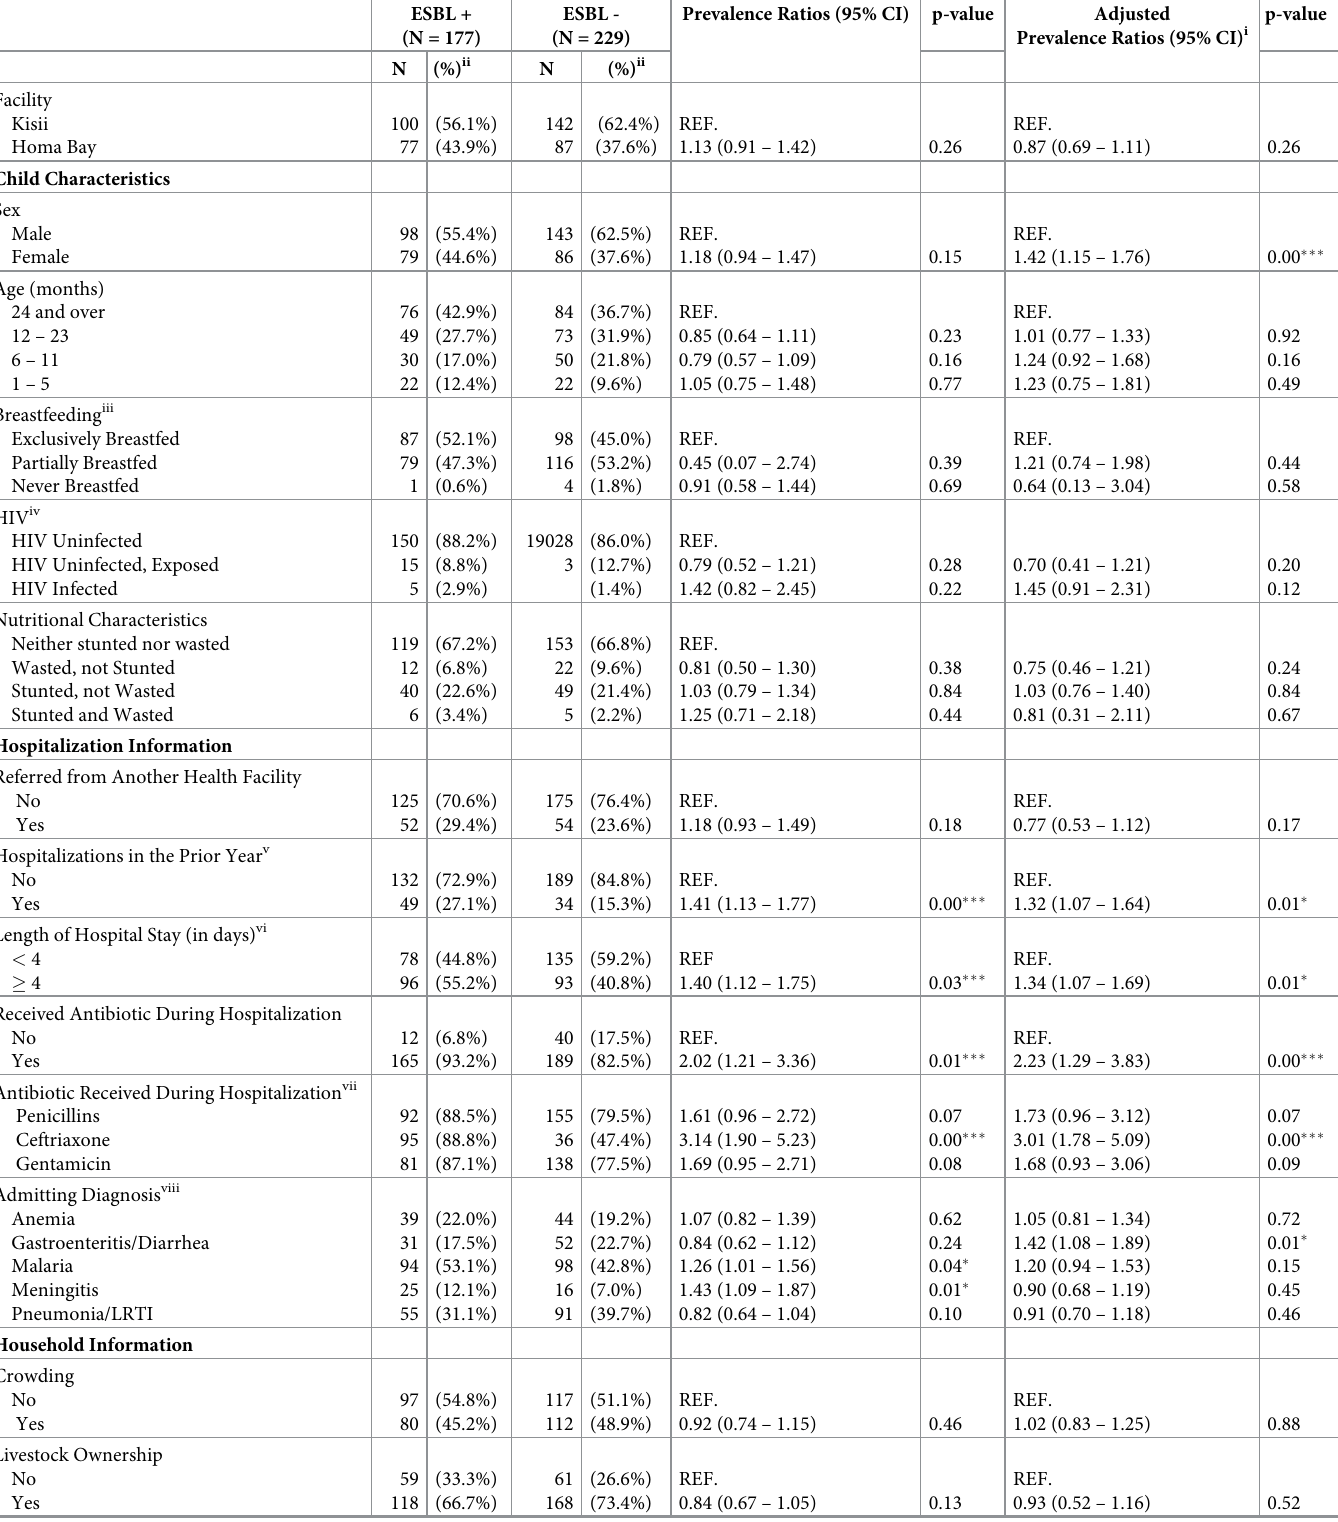
Table 2. Risk Factors for ESBL Producing E . coli from Fecal